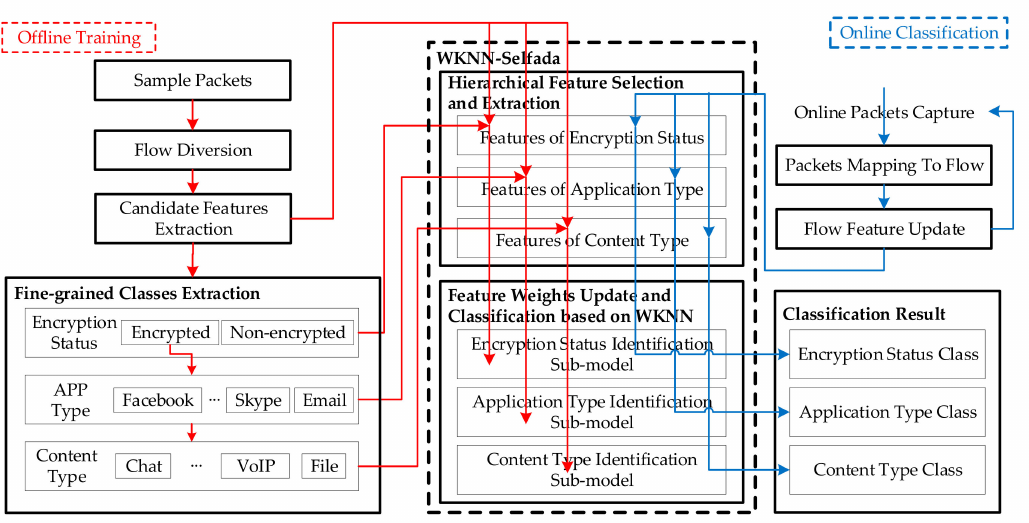
Figure 2. Framework of fine-grained real-time classification for encrypted network